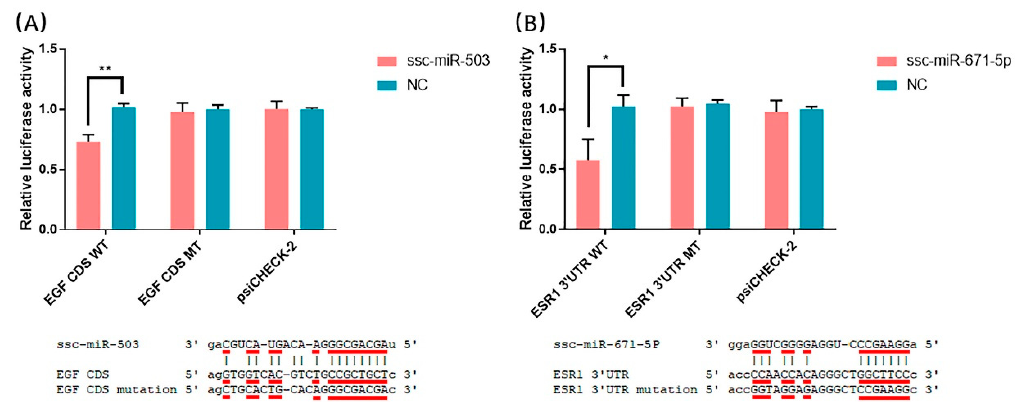
Figure 9. Validation of miRNA-gene interactions. ( A ) Validating EGF as a target of ssc-miR-503, ( B ) validating ESR1 as a target of ssc-miR-671-5p. (* p < 0.05, ** p < 0.01). WT, wild type; MT, mutant type.